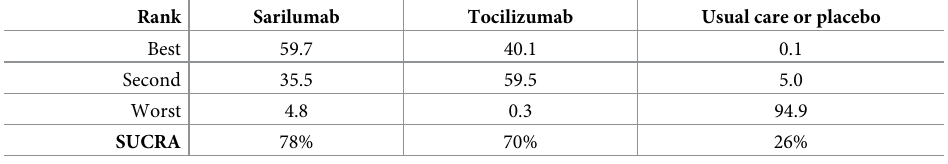
SUCRA: Surface under the cumulative ranking